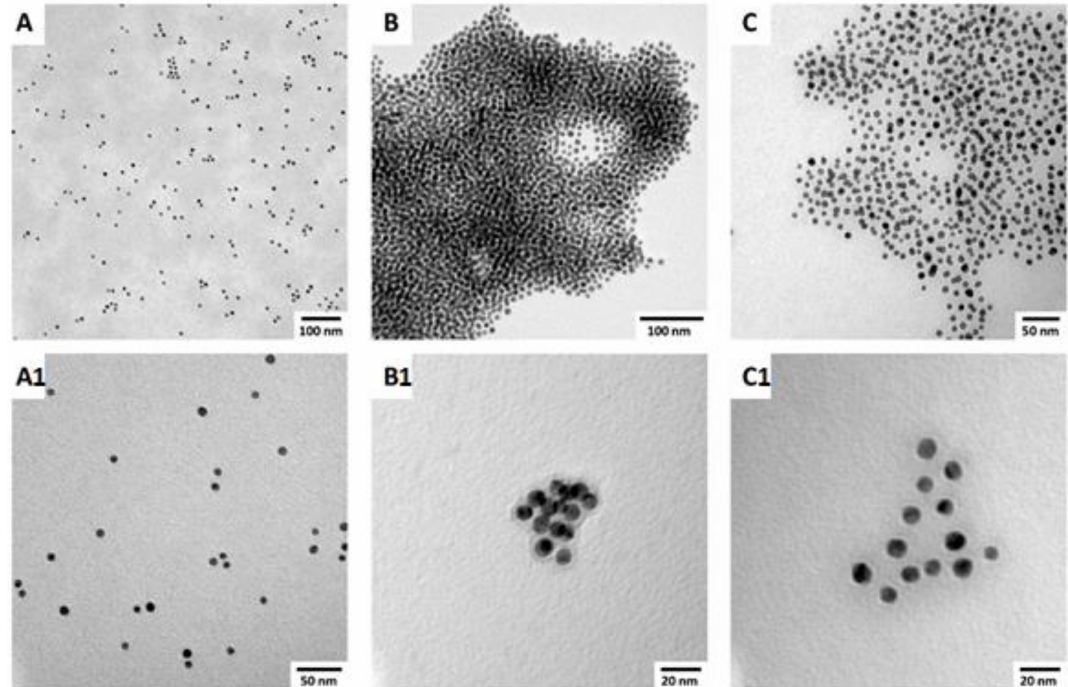
Figure 6. TEM image of AuNP2 recorded after addition of different amounts of avidin. ( A ) 0.18 equivalents (region I of Figure 5A); ( B ) 0.7 equivalents (region II of Figure 5A); ( C ) 8.5 equivalents (region III of Figure 5A); For each condition, two different magnifications are shown (top and bottom, denoted as A1 – C1 , the magnified